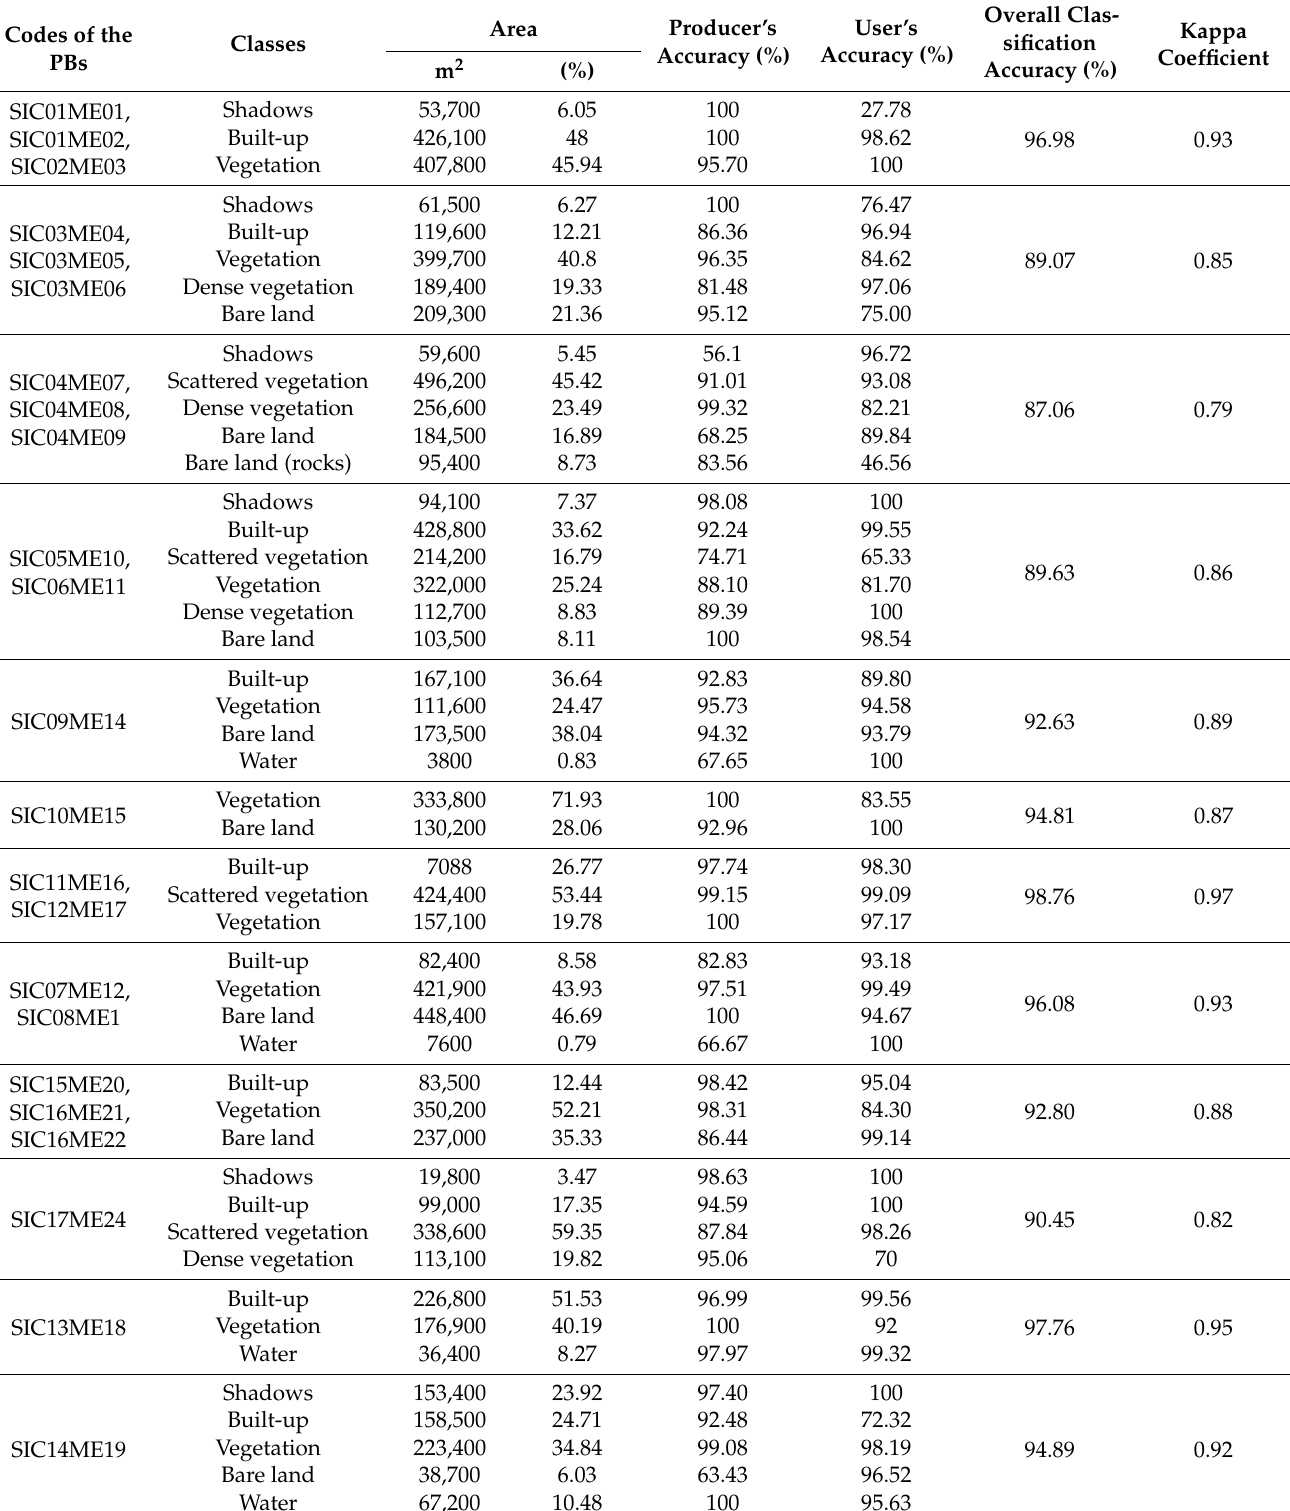
Table 5. Overall land use/land cover classification results and analysis obtained for the PBs located on the coast of Messina province. Codes of